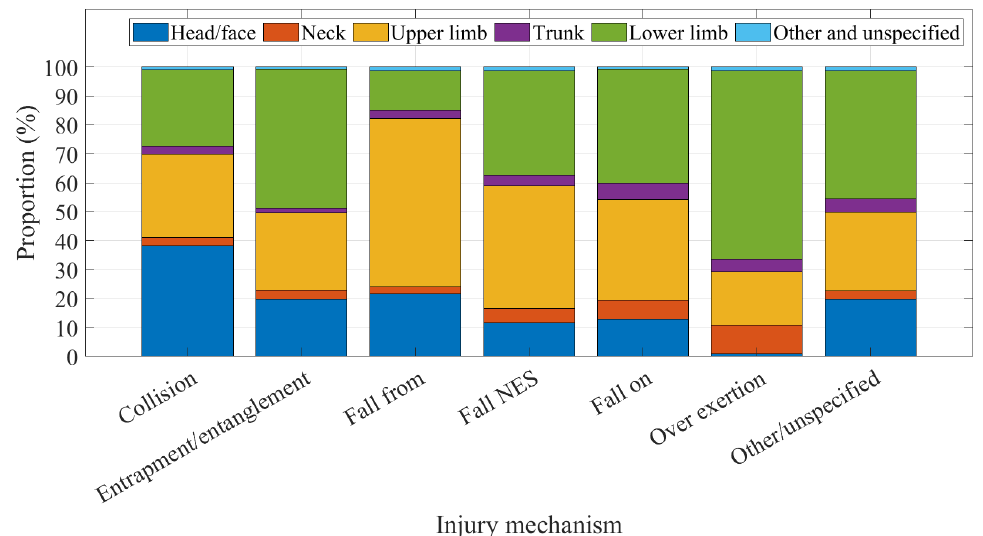
Figure 10. Injured body region by